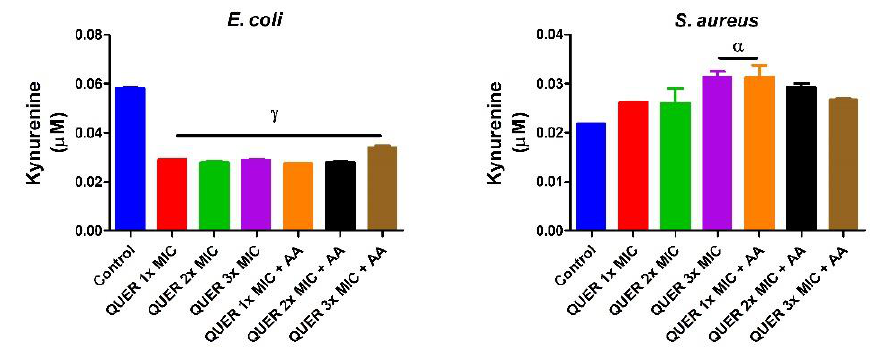
Figure 7. Kynurenine concentration in bacterial isolates following exposure to quercetin (QUER) alone or when combined with ascorbic acid (AA). Results are presented as an average of duplicate biological experiments (n = 2) with the corresponding standard error of the mean (SEM). Compared with the control or QUER 1 × MIC, α at p < 0.05 is significant, as is γ at p < 0.0001 relative to the control.